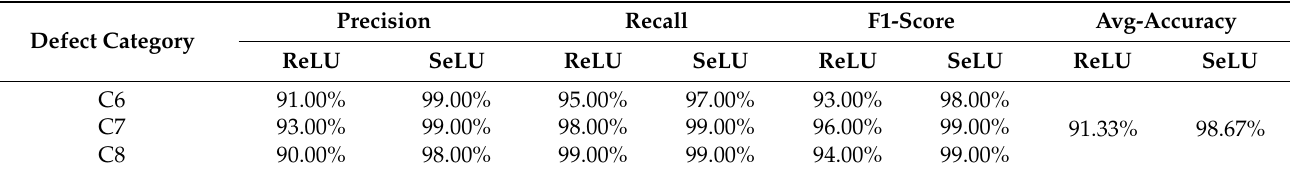
Table 4. Evaluation index of MC-DCNN based on different activation functions.